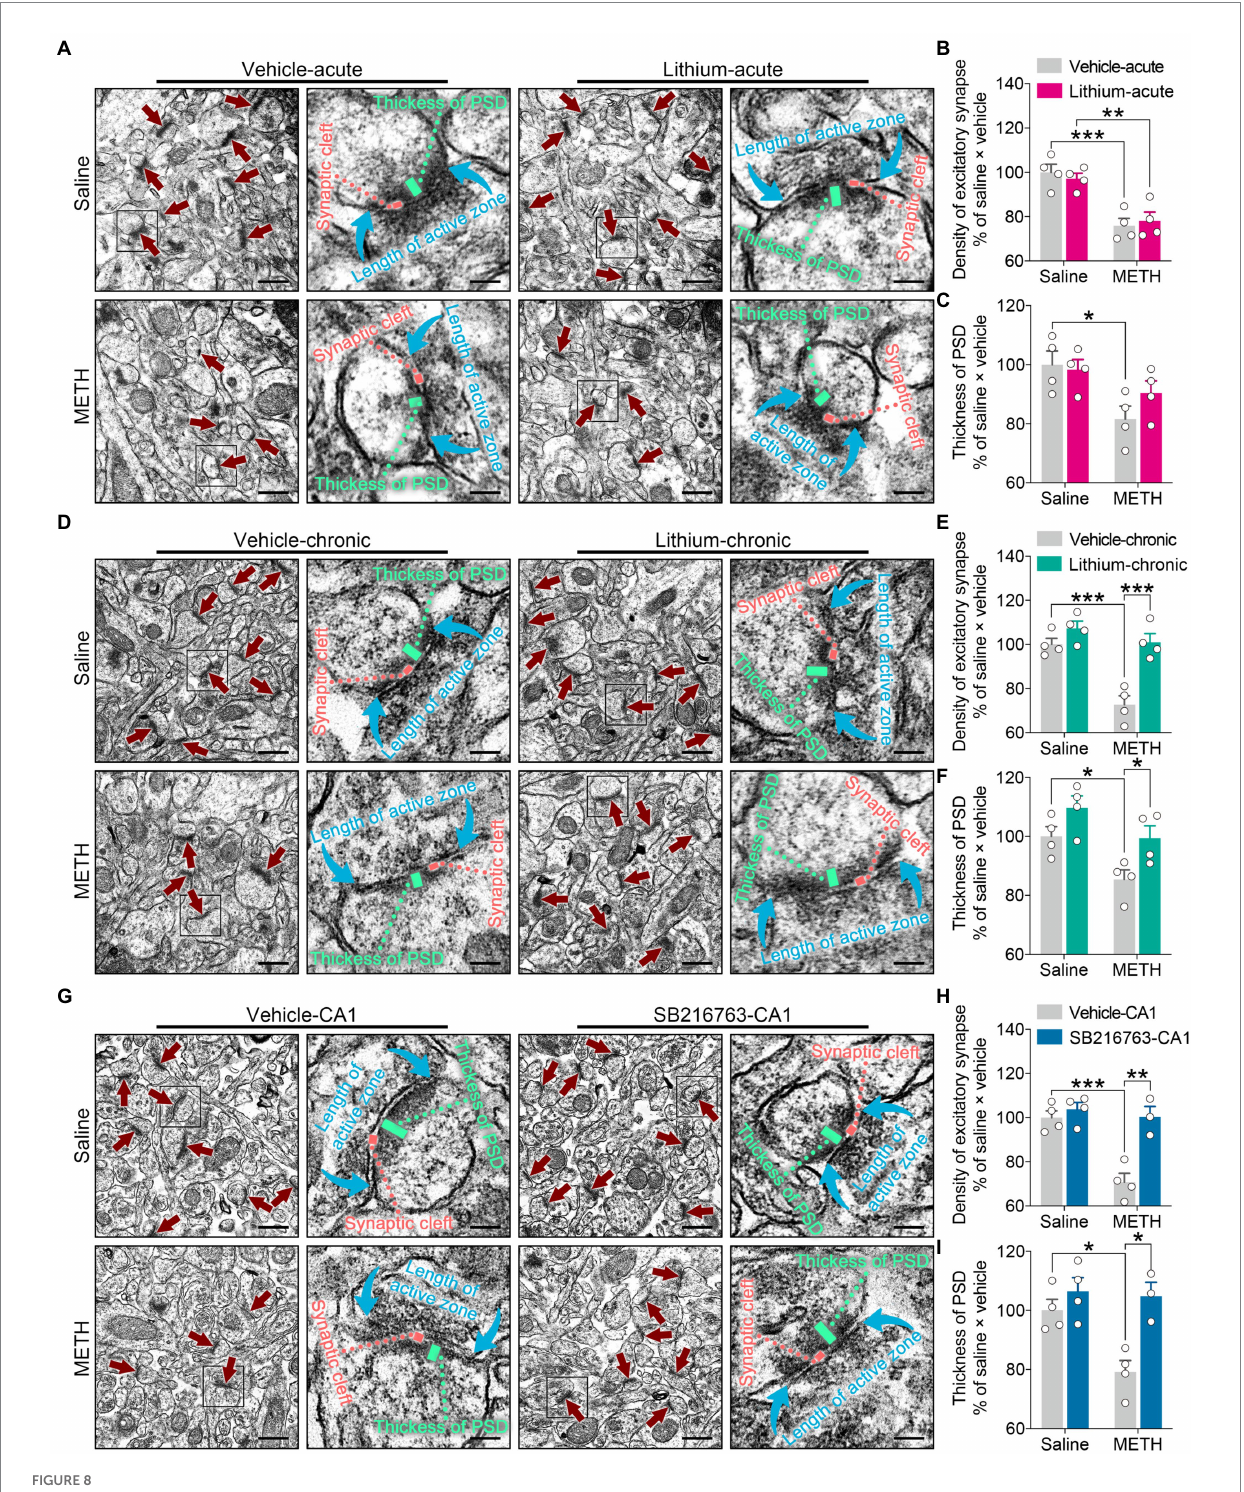
FIGURE 8 Effects of GSK3 β inhibition on synaptic ultrastructural changes in the adult DHP CA1 subregion induced by adolescent METH exposure. Compared with the effect of the acute systemic intervention (A–C) , chronic systemic intervention (D–F) and chronic intervention within CA1 (G–I) resumed adolescent METH exposure-induced alterations in synaptic ultrastructure of the DHP CA1 subregion in adulthood. Representative electron micrographs of the DHP CA1 subregion. The straight crimson arrows indicate Gray’s type-1 asymmetric synapses (excitatory synapses), the boxes indicate regions shown at higher magnification in the lower panels, and scale bars represent 500 nm under low magnification and 100 nm under high magnification (A,D,G) . Histograms show the relative changes in the total number of excitatory synapses (B,E,H) and the thickness of postsynaptic density (PSD) at the thickest part (C,F,I) . More than 60 randomly chosen excitatory synapses from each animal were analyzed. Data are presented as the mean +/ − SEM, each symbol represents the independent of a single animal; two-way ANOVA followed by the Bonferroni post hoc test; n = 4 ~ 5/group; * p < 0.05, ** p < 0.01, and *** p < 0.001, comparison between the two indicated groups. See also Supplementary Figure